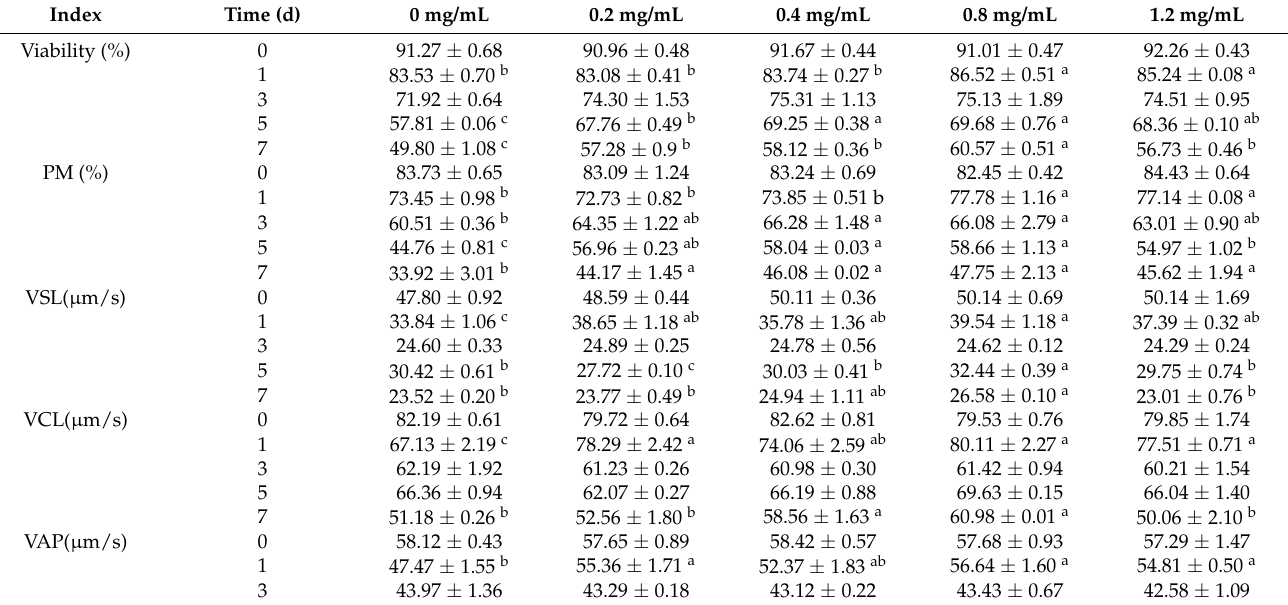
Table 1. Effects of CGA with different concentrations on kinematic parameters of chilled ram